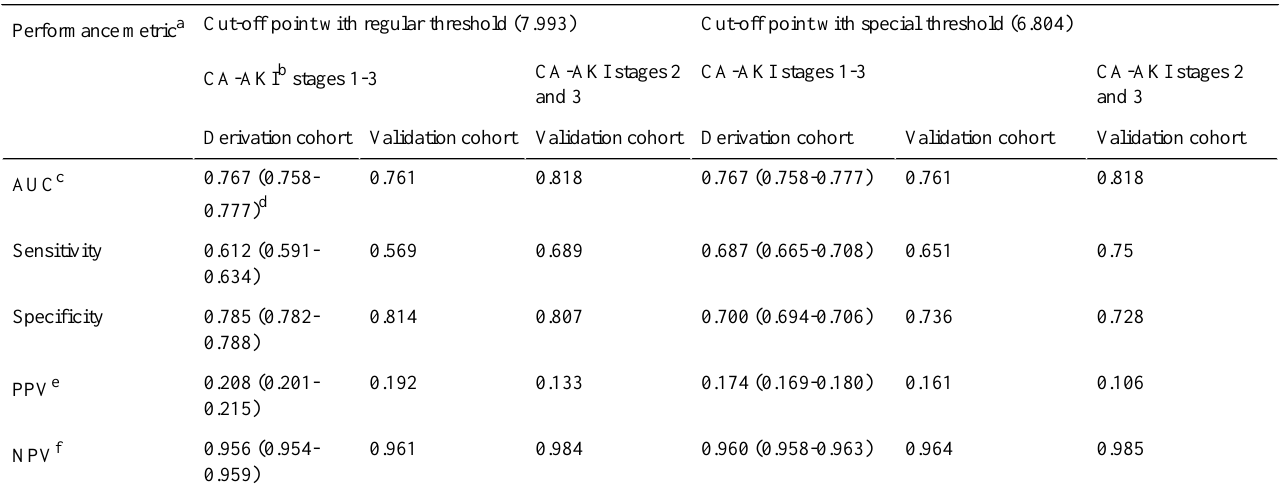
Table 4. Model performance in the derivation and validation cohorts.